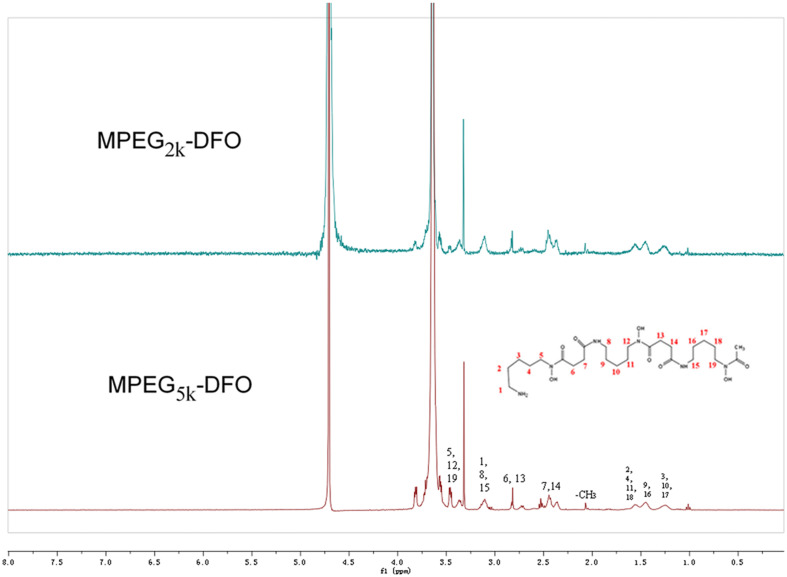
1HNMR spectra of PEGylated DFO.